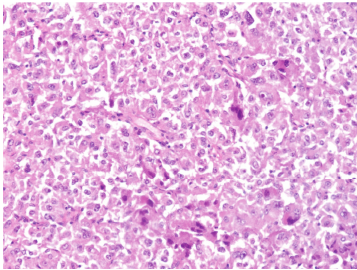
Figure 6: PAS stains carbohydrate moieties such as glycogen. This was a granular material more consistent with a